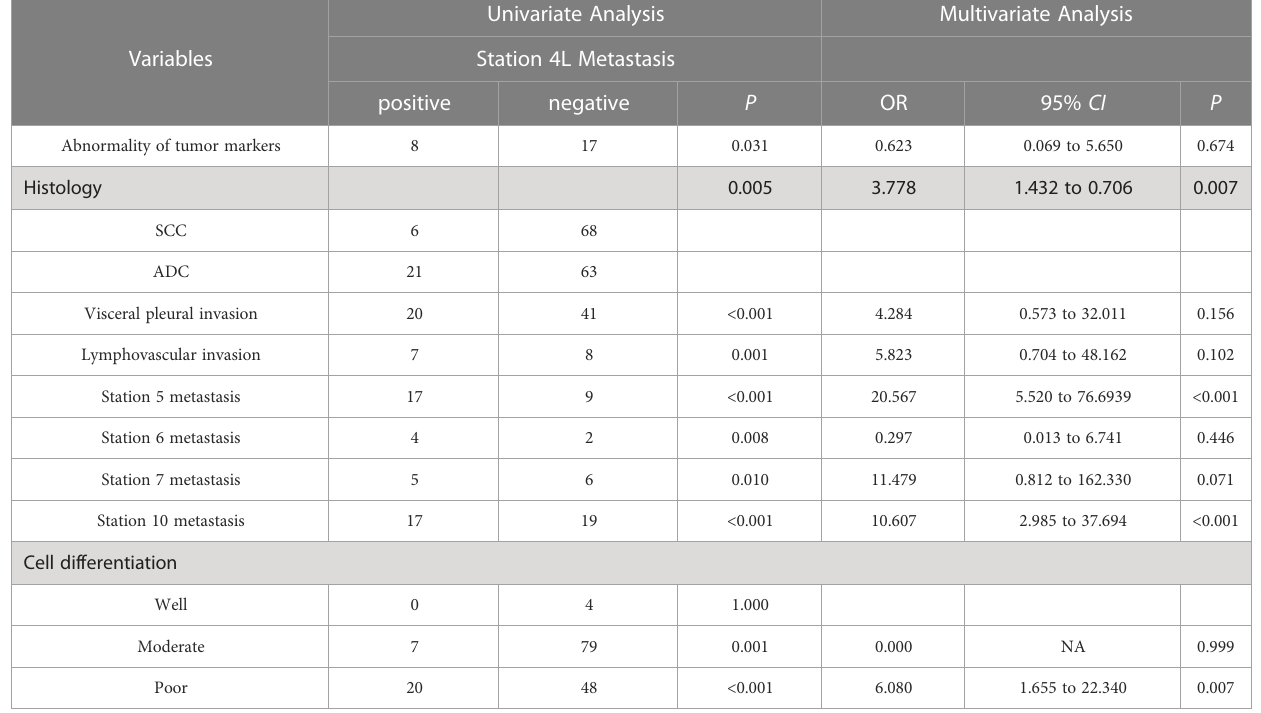
TABLE 3 Univariate and multivariate analysis of the correlation between clinicopathological factors and station 4L metastasis.